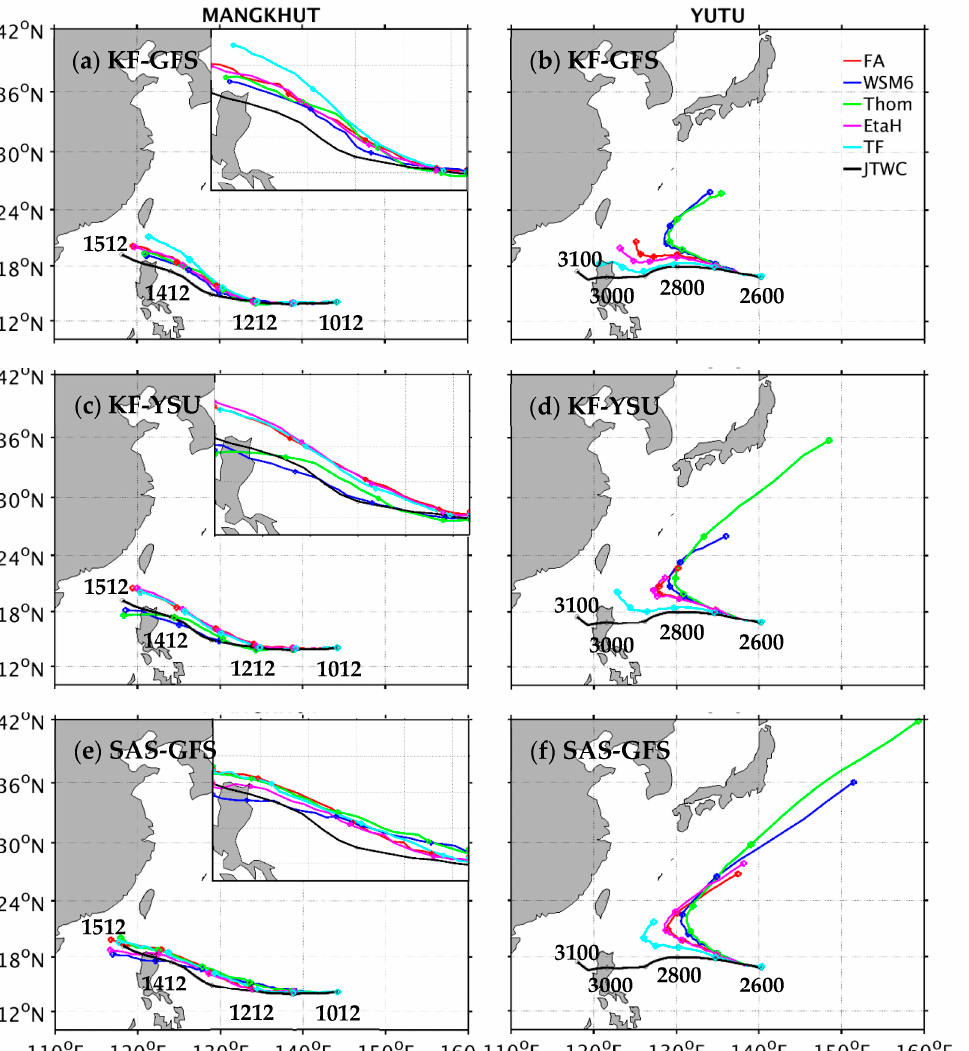
Figure A1. Simulated tracks from the cloud-microphysics sensitivity experiments for Mangkhut from 1200 UTC 10 September to 1200 UTC 15 September with the set of cumulus parameterization and planetary boundary layer schemes, ( a ) KF–GFS, ( c ) KF–YSU, and ( e ) SAS–GFS. ( b ), ( d ), and ( f ) are the same as in ( a ), ( c ), and ( e ), respectively, but for Yutu from 0000 UTC 26 October to 0000 UTC 31 October. The red, blue, green, magenta, and cyan lines denote the cloud-microphysics schemes FA, WSM6, Thom, EtaH, and TF, respectively. The black line denotes the JTWC’s best track. Circles mark the typhoon centers every 24 h, associated with the numbers indicating UTC time.